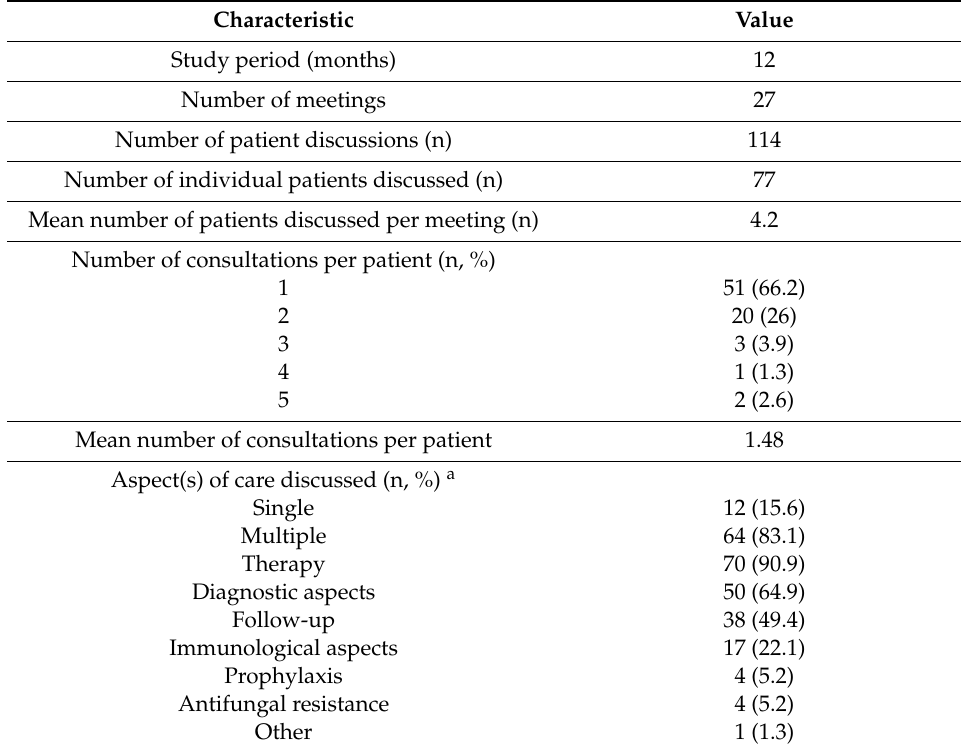
Table 1. Meeting characteristics in the period studied (1 July 2017 to 30 June